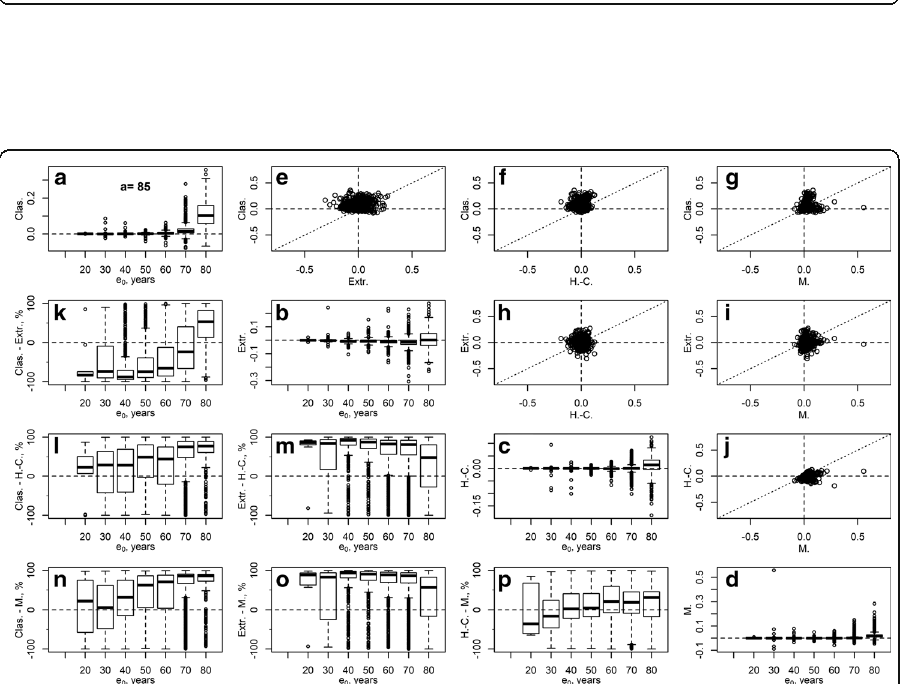
Fig. 2 Estimation errors in life expectancy at birth obtained by methods: the classical method ( “ Clas. ” ), extrapolation based on 20-years-long age base ( “ Extr. ” ), Horiuchi-Coale method ( “ H.-C. ” ), and Mitra method ( “ M. ” ). The main diagonal (panels a – d ): boxplots, as a function of life expectancy at birth, of estimation errors in each of the methods; above the diagonal (plots e – j ): scatterplots of errors in pairs of methods as indicated at axes of the plots; below the diagonal (plots k – p ): boxplots, as a function of life expectancy at birth, of percentage differences of absolute errors (5) of pairs of methods as indicated at vertical axes. Female populations, open age interval